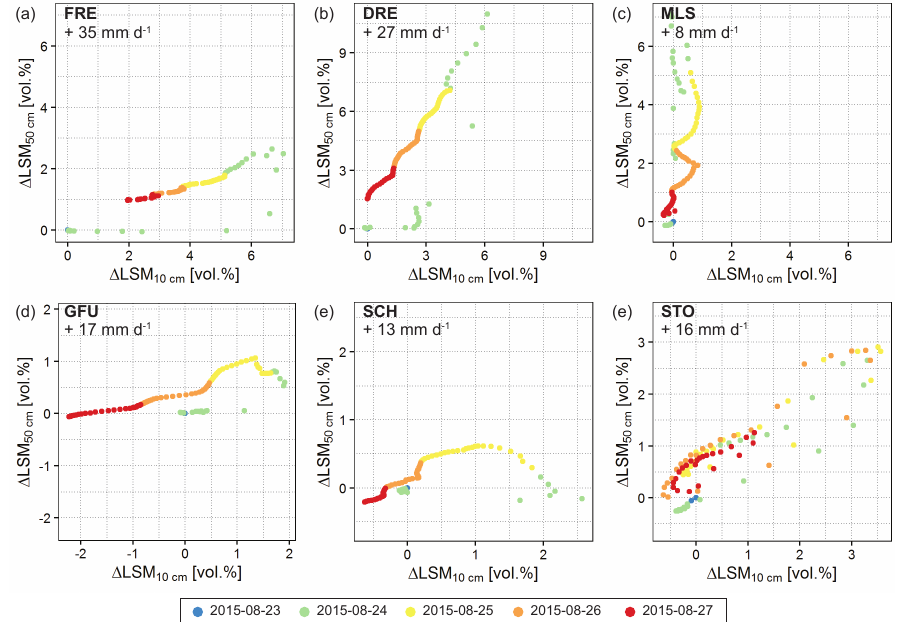
Figure 10. Moisture orbit at each SOMOMOUNT station for one precipitation event between the 23 and the 27 August 2015. The LSM values are given as hourly mean and expressed as the change of absolute value compared to the first measurement (23 August at 23:00). The daily precipitation sums recorded (FRE, DRE and MLS) and extrapolated (GFU, SCH and STO) for the 24 August are